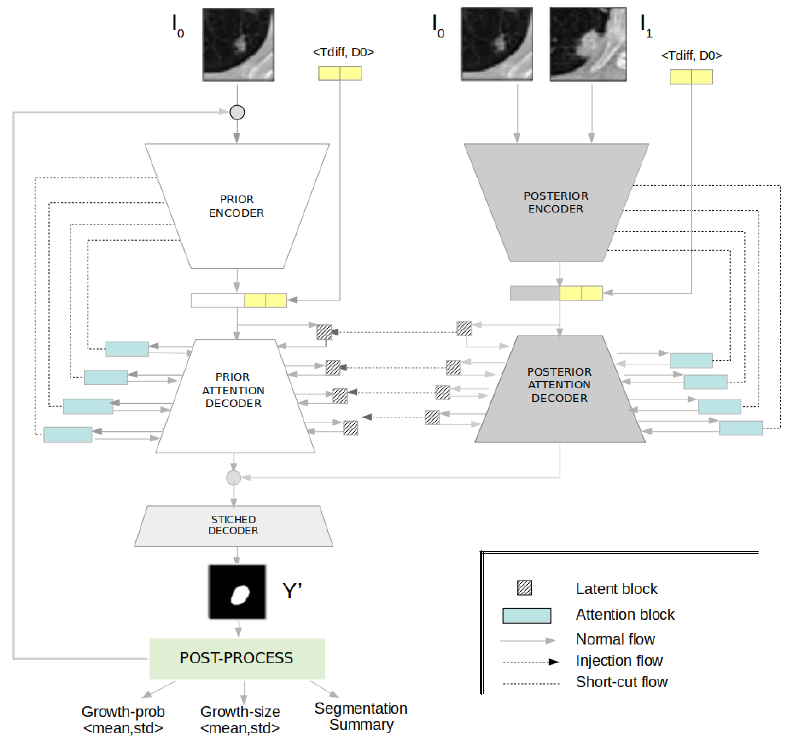
Figure 1. Overview of the U-HPNet composed of two subnets. The prior (on the left), the posterior (on the right), and the post-process module (at the bottom) are aimed at reporting the estimated future growth prediction, size and appearance with the associated